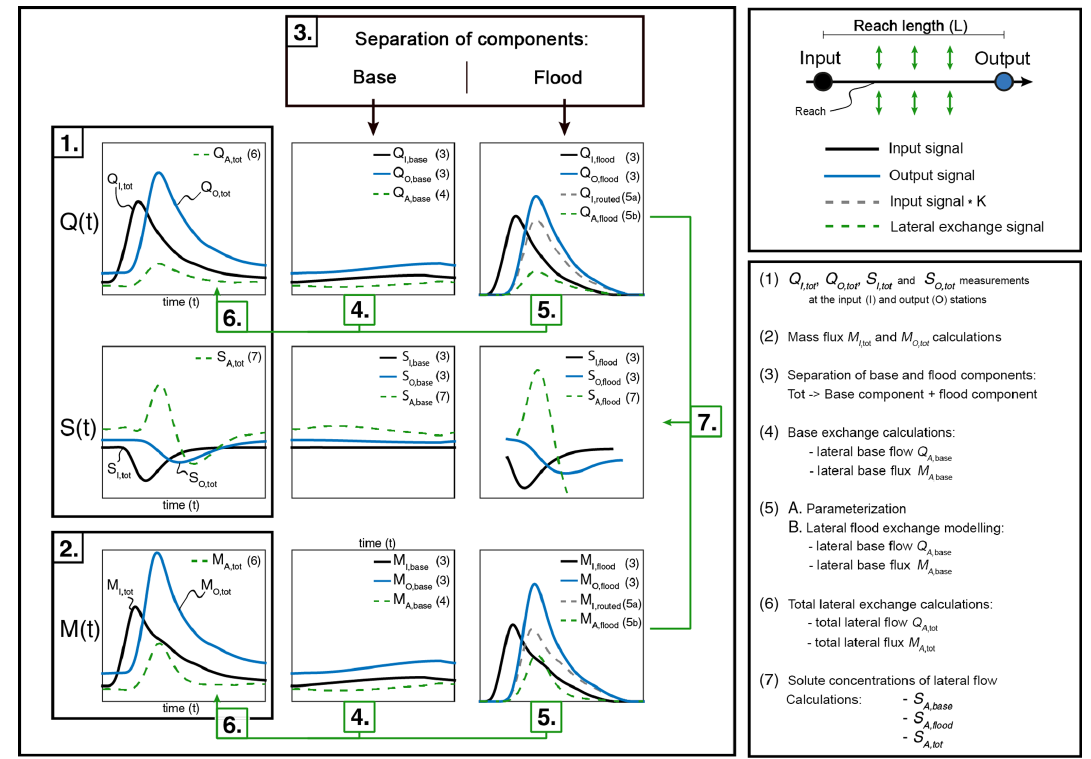
Figure 2. Framework to investigate lateral exchange dynamics of water flows and solute fluxes along a channel reach.